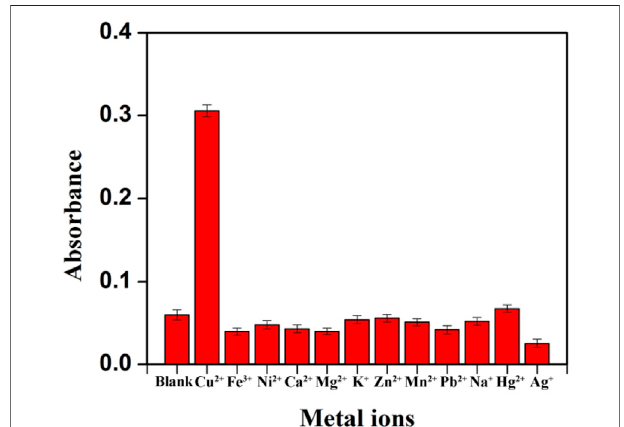
FIGURE 5 | Study on the selectivity of the established Cu 2+ assay after the addition of masking agents (The concentration of Cu 2+ was 1.0 μ M, other metal ions concentration was ten-fold of Cu 2+